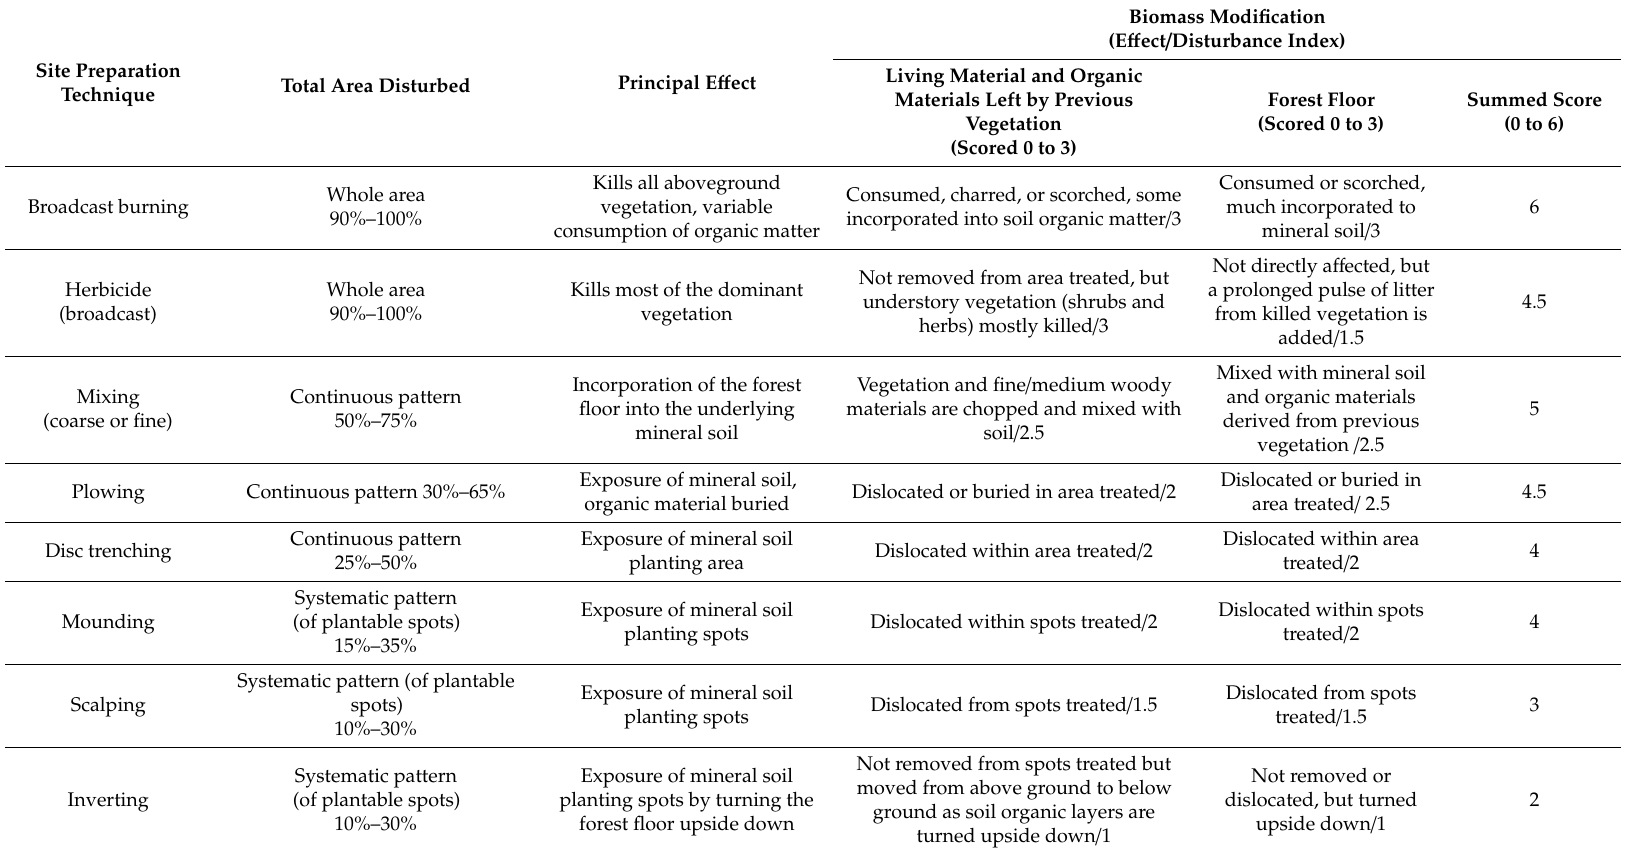
Table 1. Attributes of eight site preparation techniques commonly used in boreal mixedwood